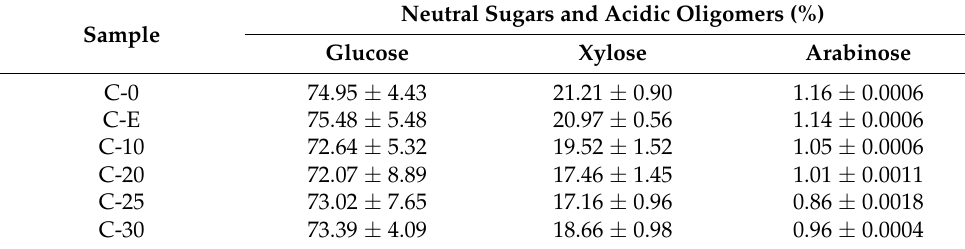
Table 2. Sugar composition of fibers after different treatment stages.